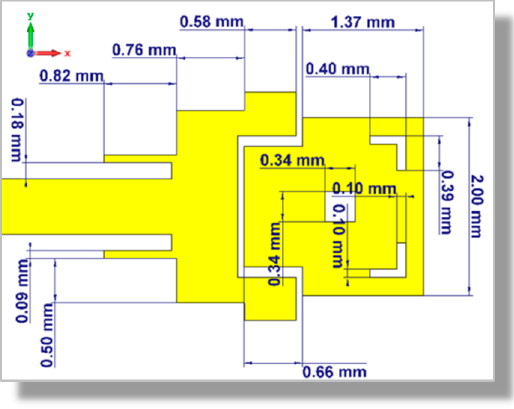
Figure 11. Optimum dimensional parameters of the dual-band microstrip patch antenna for operation.